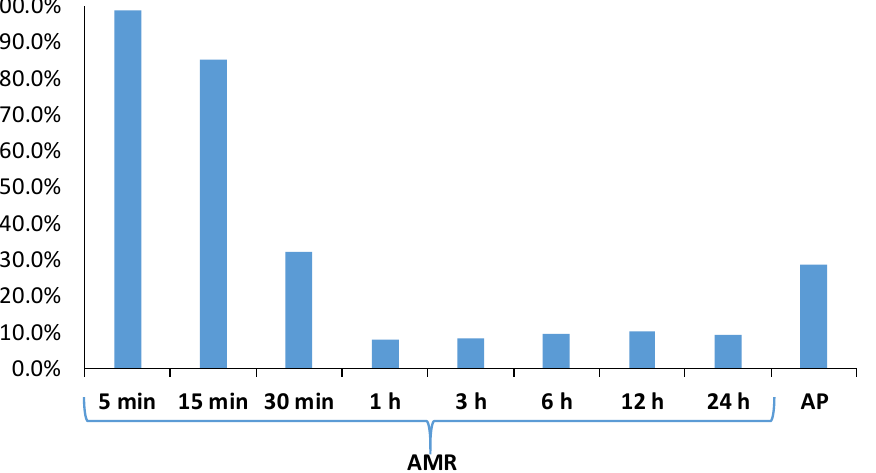
Figure 7. MK test for Viterbo rain gauge: percentages of synthetic times series with Zs > 1.96, for different timescales.